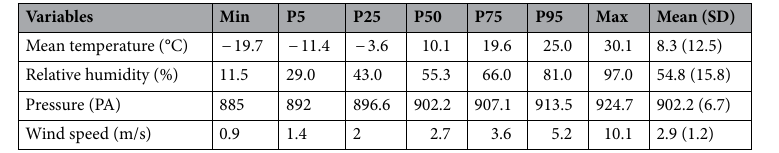
Table 2. Descriptive summary of climate variables in Baotou during 2014–2018. Min. minimum, P5 5th percentile, P25 25th percentile, P50 50th percentile (median), P75 75th percentile, P95 95th percentile, Max. maximum, SD standard deviation.